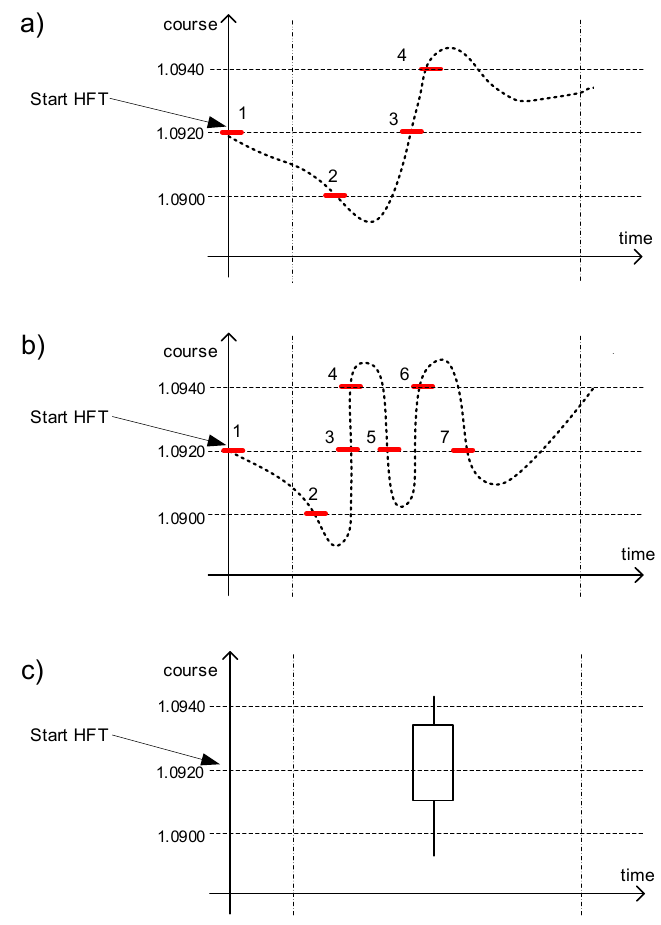
Figure 5. Different possible course trajectories and number of transactions ( a , b ) “inside” the same candle ( c ). candle ( c